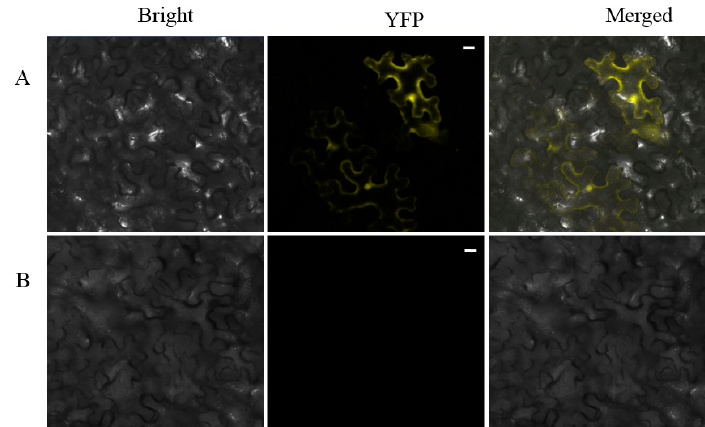
Figure 5. Bimolecular fluorescence complementation (BiFC) assay demonstrating the interaction between SjAUREO and RPS6 in planta. 40X magnification of micrographs at 48 h post-infiltration from plants co-expressing nEYFP-SjAUREO and cEYFP-RPS6 ( A ), with nEYFP and cEYFP ( B ) are served as negative control, are shown in N. benthamiana . Images are representative of three separate infiltrations from two independent experiments. Scale bars: 20 µm.